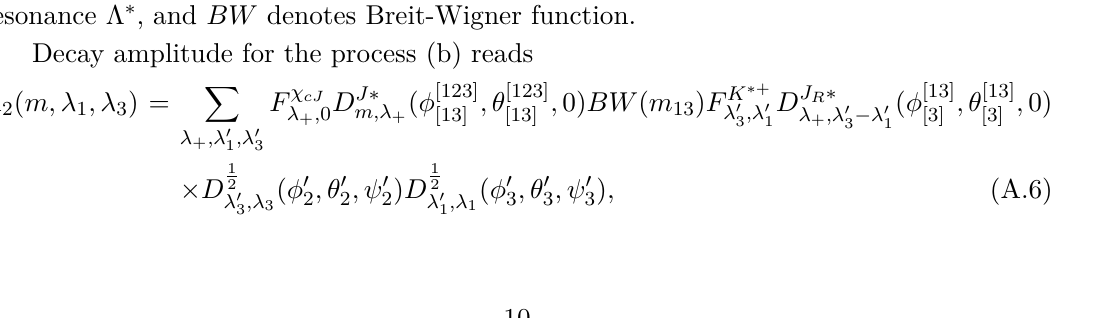
Figure 7 . Helicity system of the decay χ cJ → Λ ∗ ¯Λ , Λ ∗ → nK 0